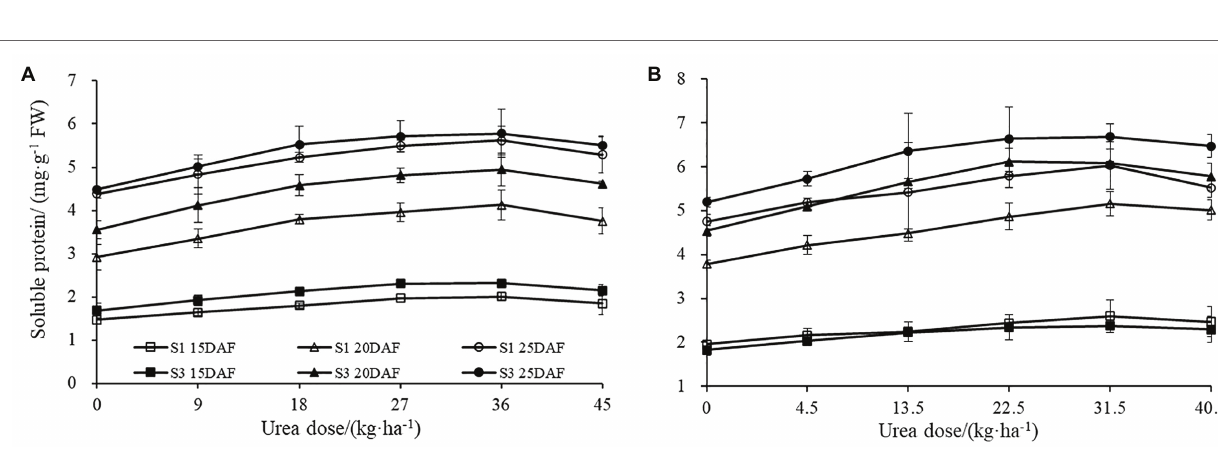
FIGURE 2 | The boll shell soluble protein content under different urea doses in 2017 (A) and 2018 (B) . FW represents the fresh weight of the sample, DAF represents the abbreviation of “days after flowering,” and S1 and S3 represent the Sikang 1 and Sikang 3, respectively.